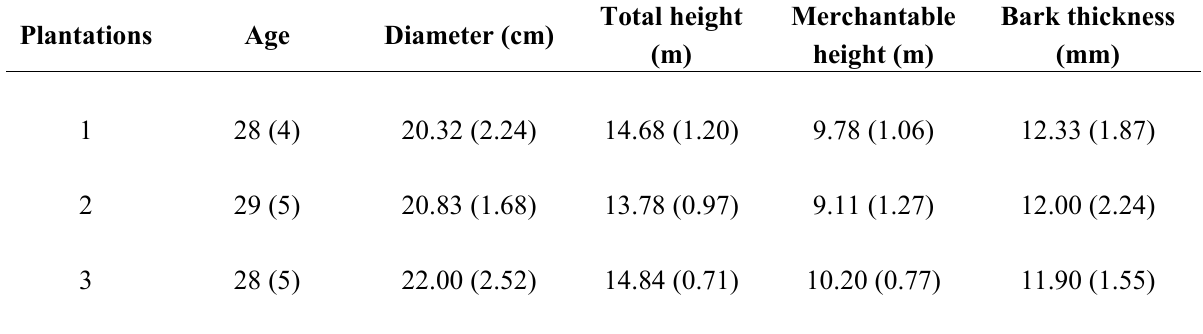
Table 1. Mean values and standard deviation in parentheses of trees